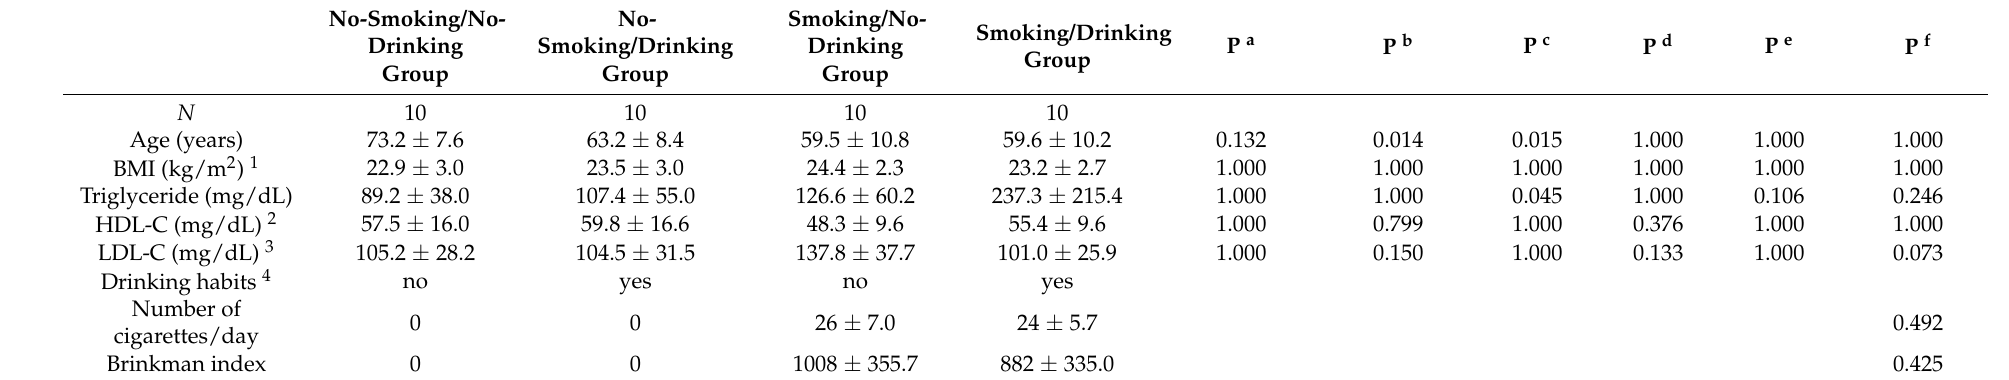
Table 1. Characteristics of the